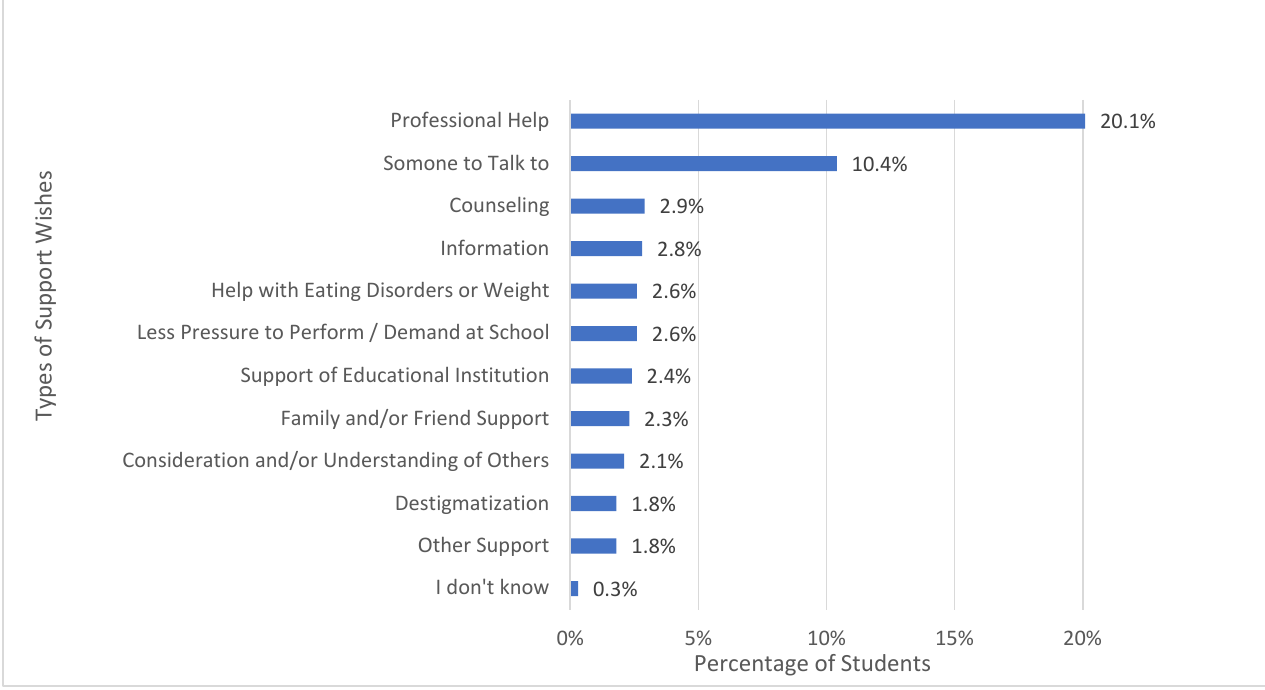
Figure 1. Percentages of school students who mentioned a certain category of support. Statements could be assigned to several categories at the same time.